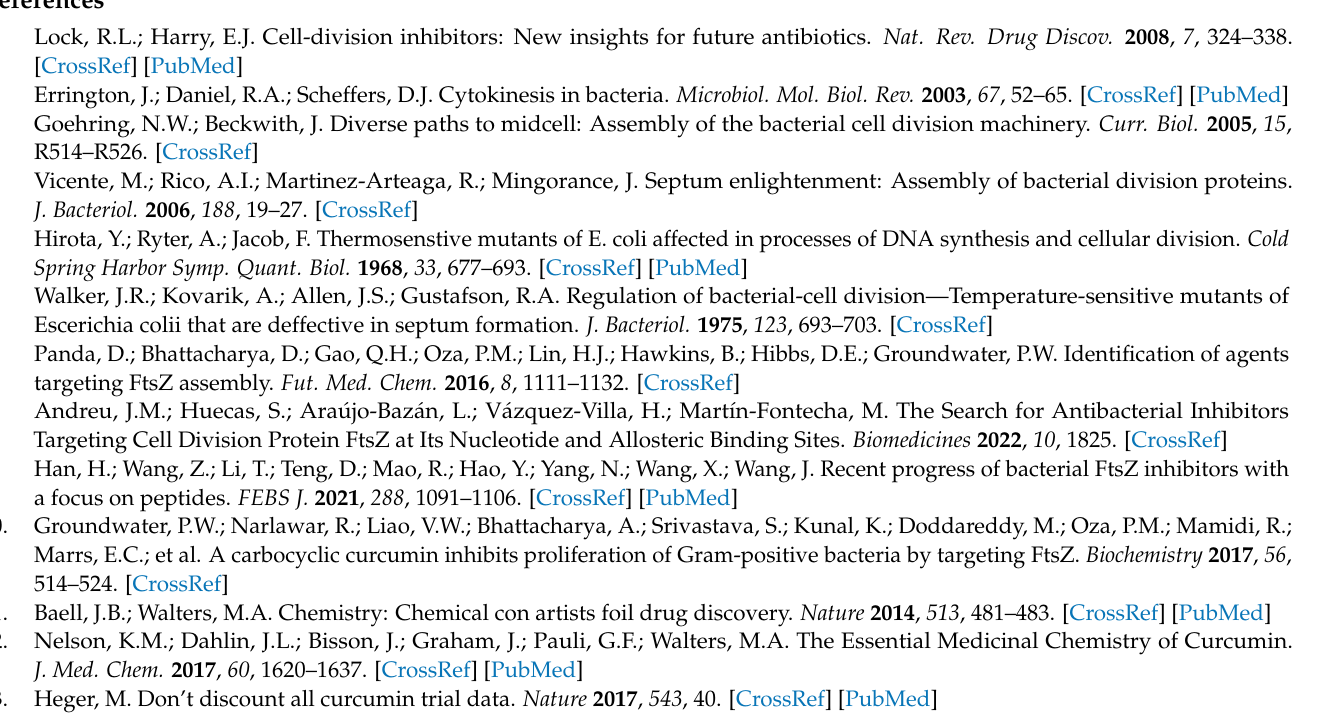
ment for 1 . Table S2: Atomic coordinates ( × 10 4 ) and equivalent isotropic displacement parameters (Å 2 × 10 3 ) for 1 . U(eq) is defined as one third of the trace of the orthogonalized U ij tensor. Table S3: Bond lengths [Å] and angles [ ◦ ] for 1 . Table S4: Anisotropic displacement parameters (Å 2 × 10 3 ) for 1 . The anisotropic displacement factor exponent takes the form: − 2p 2 [ h 2 a* 2 U 11 + . . . + 2 h k a* b* U 12 ]. Table S5: Hydrogen coordinates ( × 10 4 ) and isotropic displacement parameters (Å 2 × 10 3 ) for 1 . Figure S1: Compound 3 causes aggregation of Bs FtsZ. Transmission Electron Microscopy images of Bacillus subtilis FtsZ ( Bs FtsZ) filaments formed in the presence and absence of 3 . Bs FtsZ (5 µ M) in PKM buffer was incubated without and with 20 µ M 3 for 20 min at 25 ◦ C before polymerizing in the presence of 1 mM GTP. Scale bar indicates 1 µ m. This experiment was performed three times. HPLC chromatograms for compounds 2 and 3